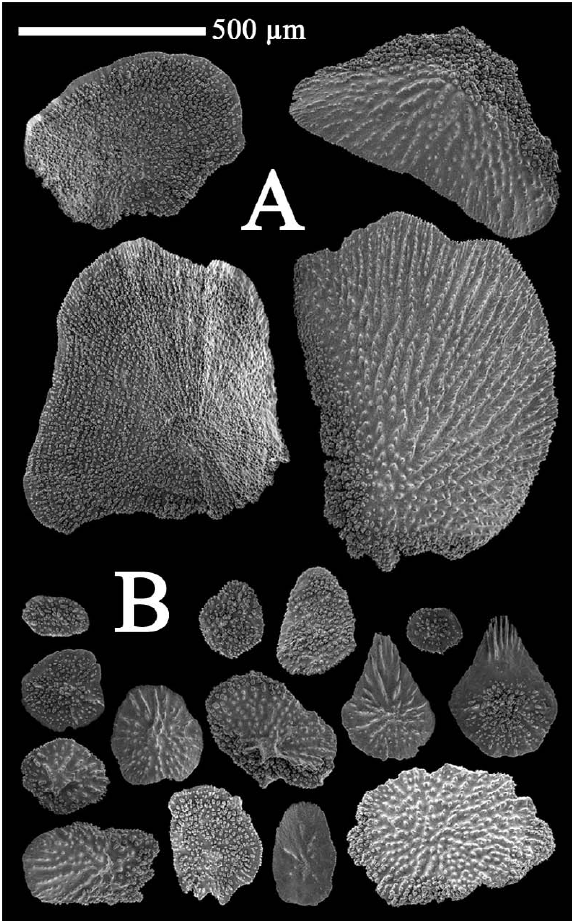
Fig . 7. – Thouarella sardana n. sp., holotype ZiZMH c11740: body scales (a); coenenchymal scales